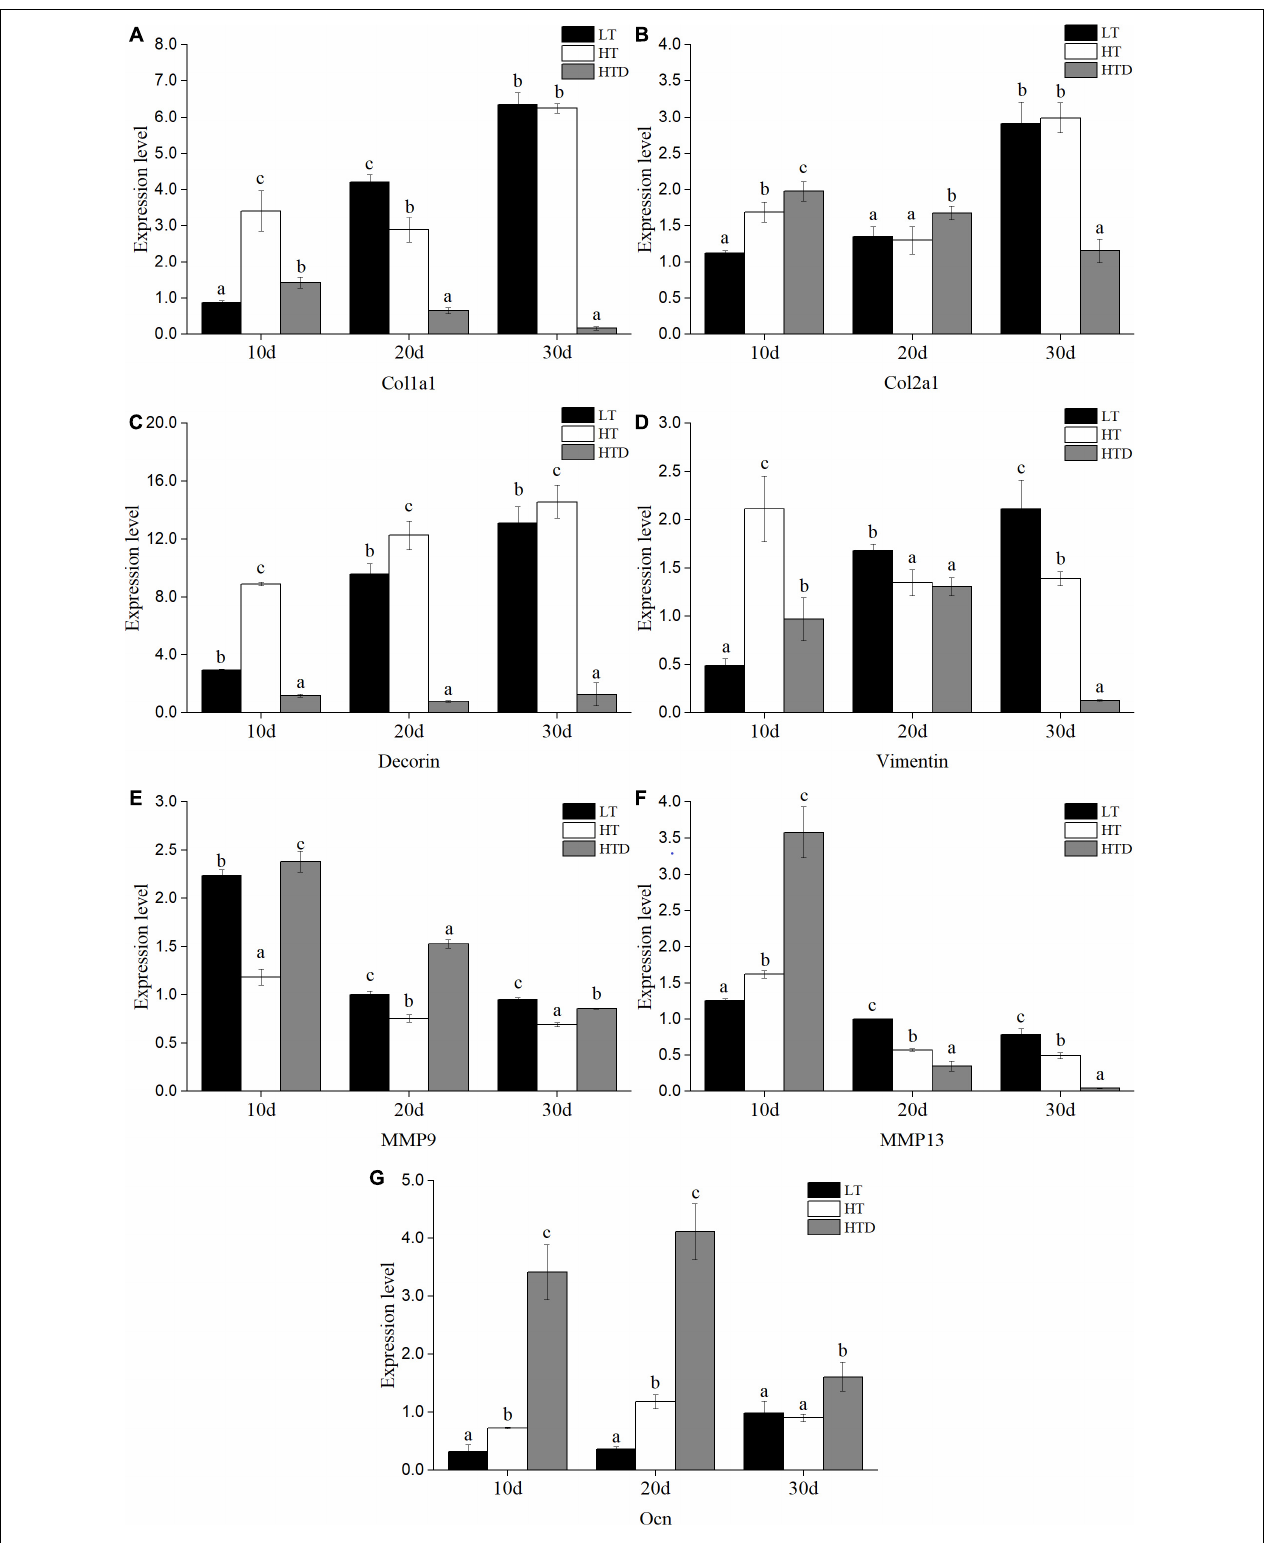
FIGURE 5 | The expression levels of ECM components ( A : Col1a1, B : Col2a1, C : Decorin, D : Vimentin, E : MMP9, F : MMP13, G : Ocn) in the spine of juvenile T. ovatus (LT, low temperature group; HT, high temperature group; HTD, high temperature deformity group).